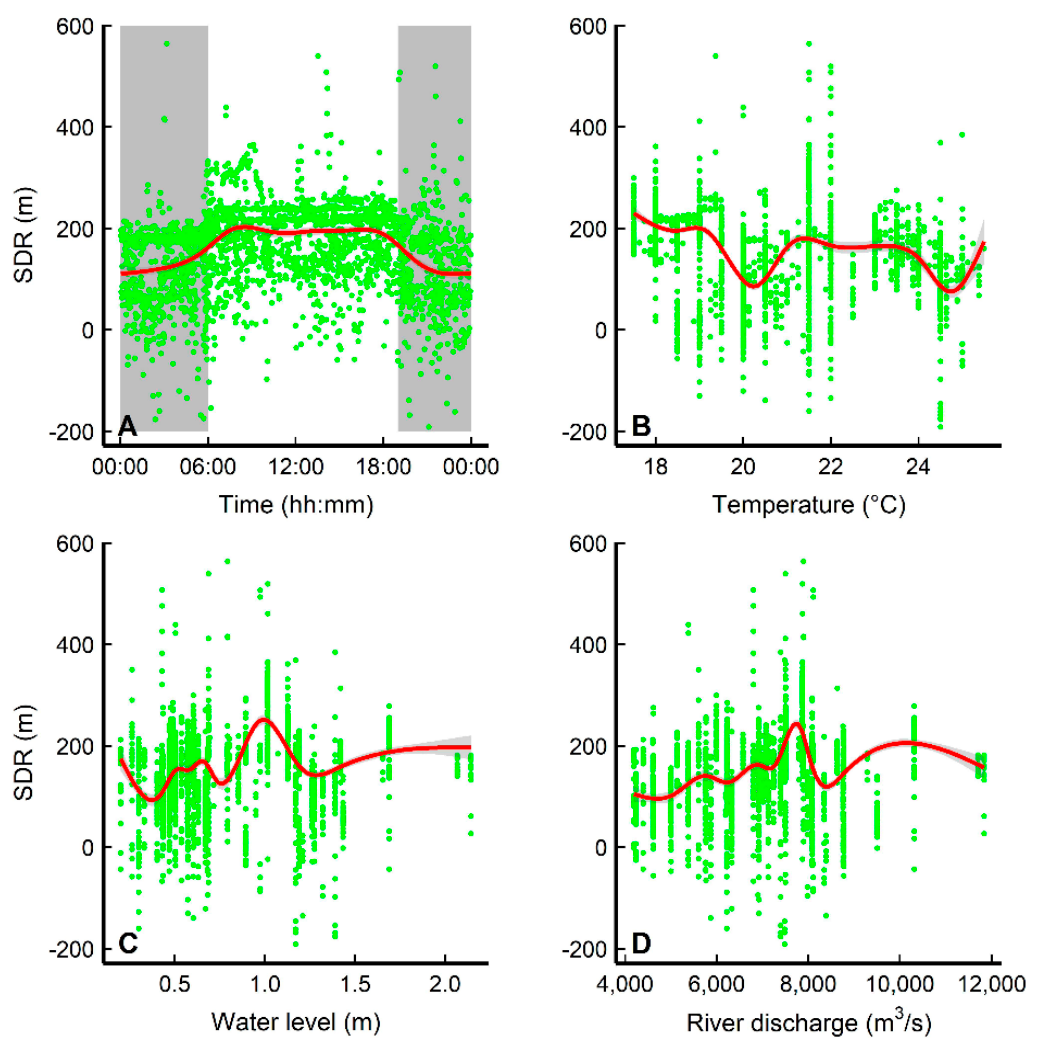
Figure 5. Effects of diel phase, temperature, water level, and river discharge on the shortest distance to riverbanks (SDR) of common carp. A smoothing (gam) curve with a span width of 0.5 was added for visual interpretation.